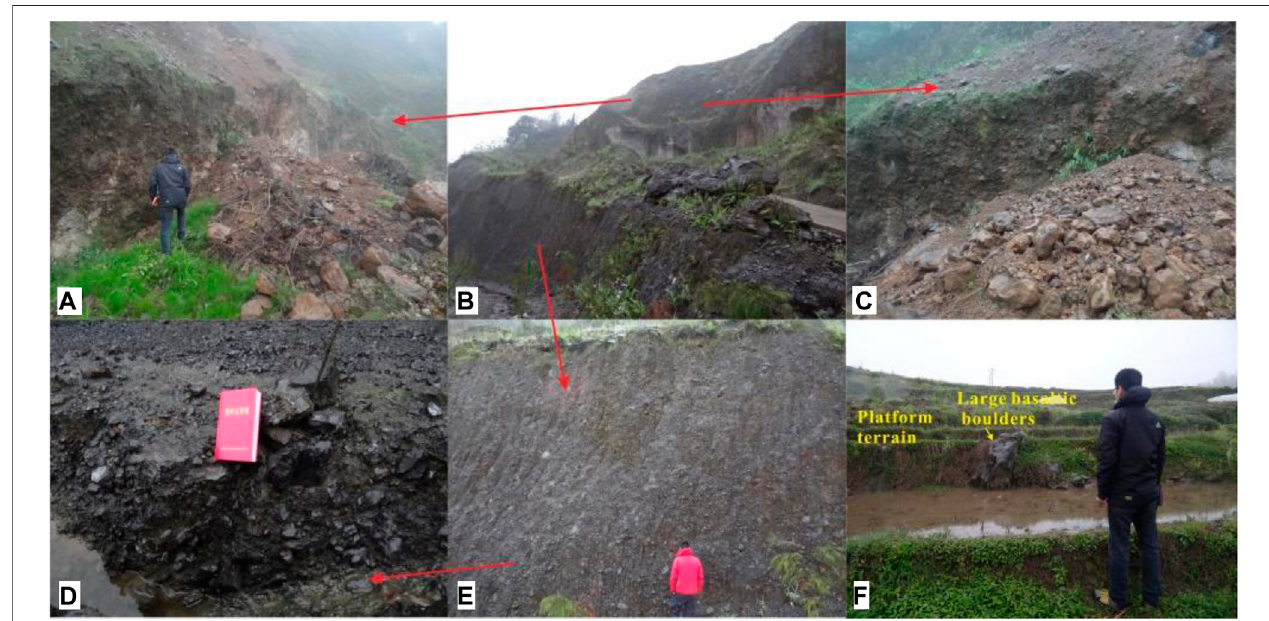
FIGURE9| LandslidedepositsdistributedaroundYuanpingVillage. (B) LandslidedepositsinexcavationatobservationpointD032showthetypicalaccumulation characteristicsoftheinversegradingstructure. (A,C) Therearemanylargerocksandbouldersintheupperpartofthelandslideaccumulation. (D,E) Thelowerpartofthe landslide accumulation is mainly composed of fi ne particles such as gravel and breccia. (F) Large basaltic boulders distributed on a platform at observation point D031.